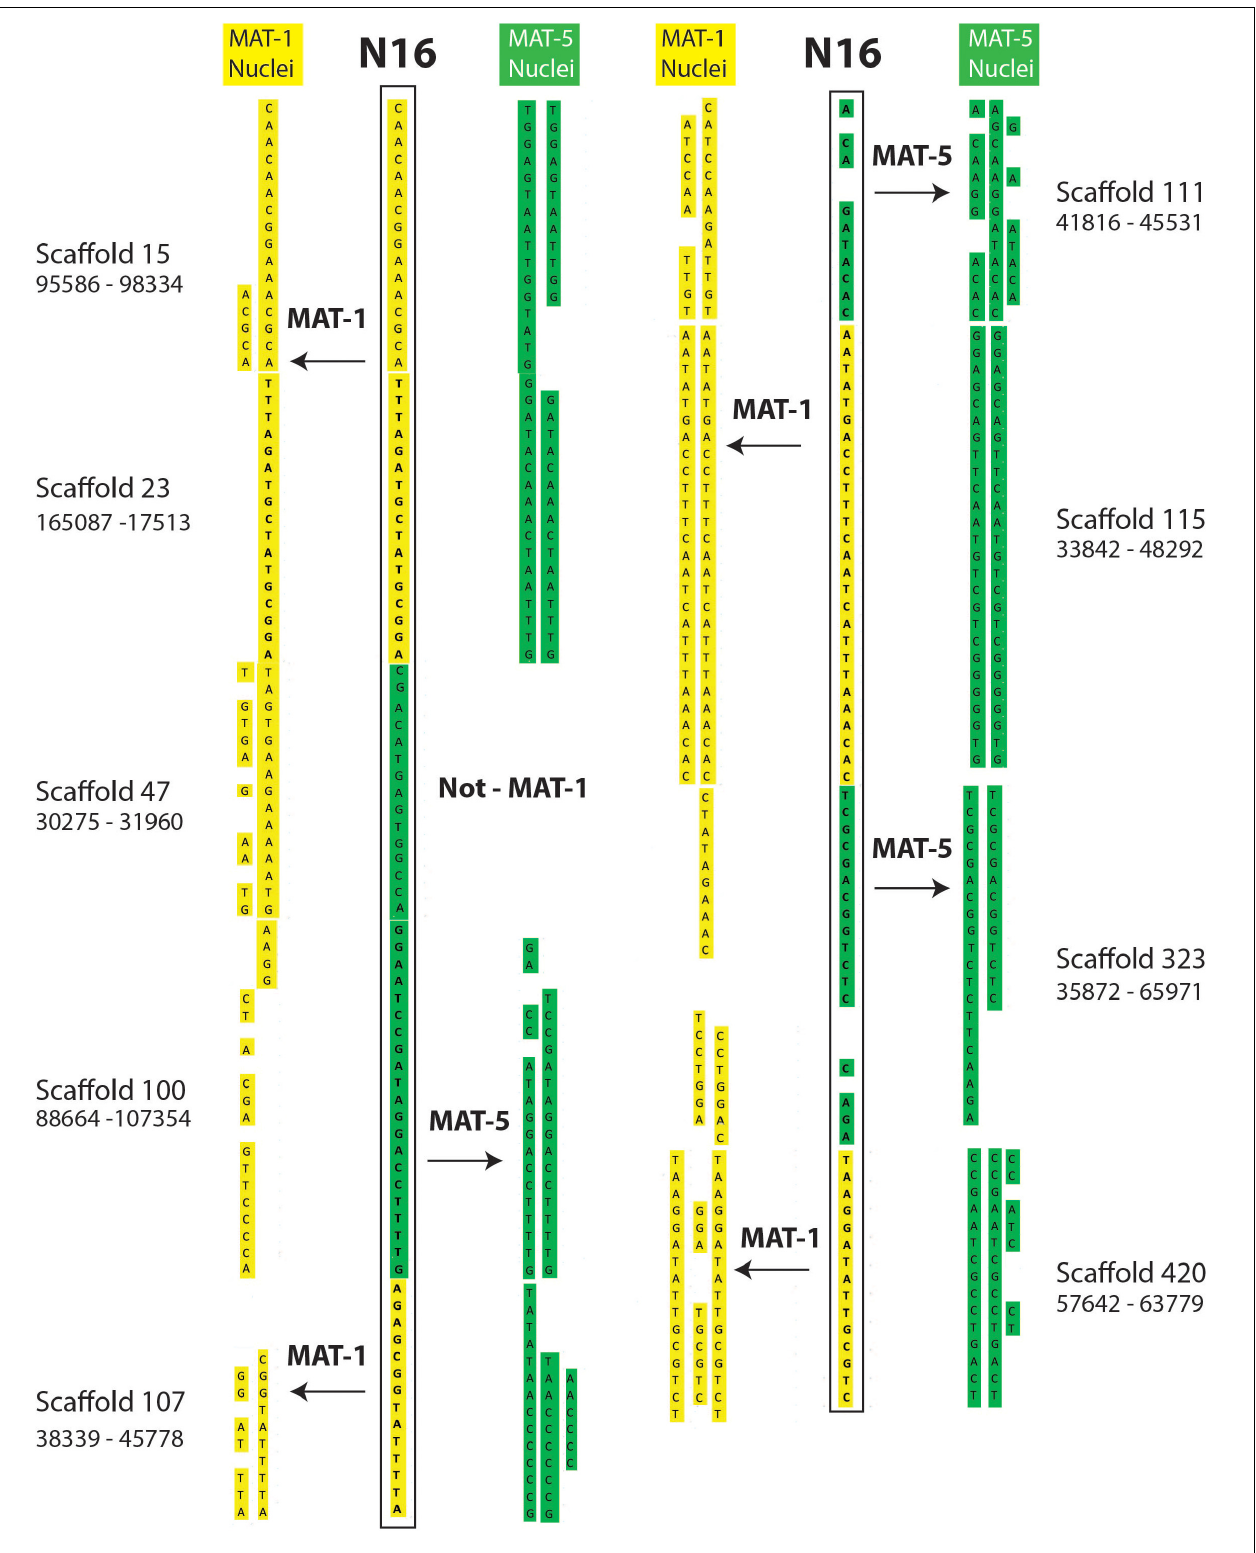
FIGURE 2 | Examples of inter-nucleus recombination in a nucleus of the dikaryotic isolate SL1. The regions are found along homozygous regions present only once in the reference genome of SL1. The nucleus 16 of SL1 carries a genotype that is overwhelmingly similar to nuclei carrying the MAT-1 locus (yellow). In several instances, however, the SN16 is found to switch alleles to carry the other co-existing genotype (green) over several kilobases.